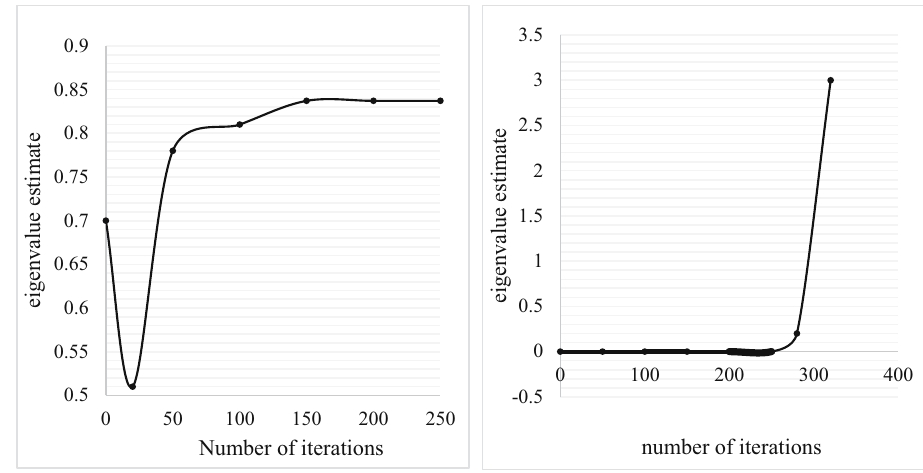
Figure 9: Oja algorithm eigenvalue calculation numerical curve.